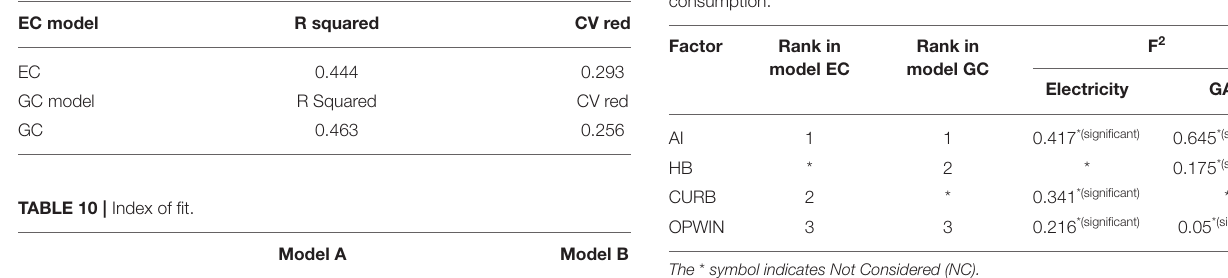
TABLE 9 | R2 value and stone cal sealer index.